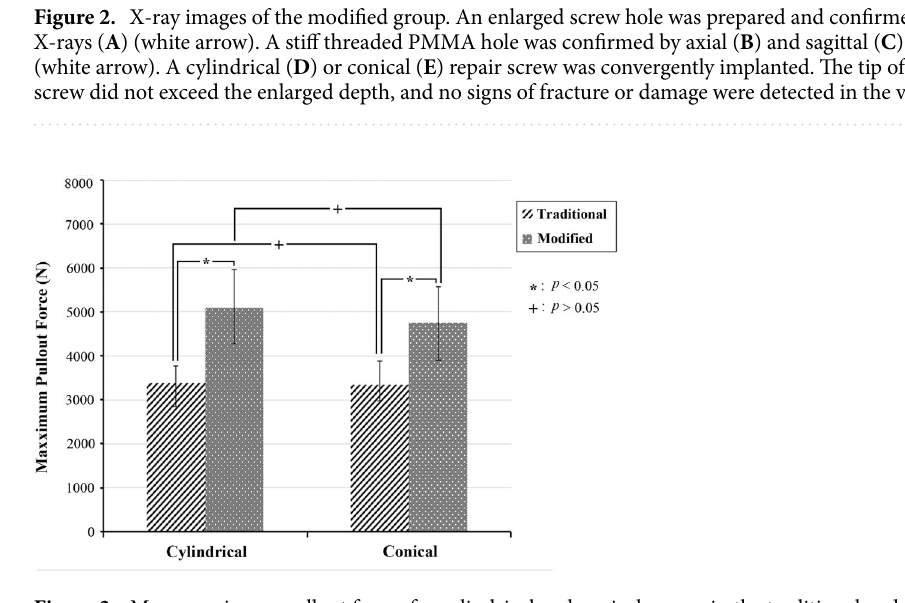
Figure 3. Mean maximum pullout forces for cylindrical and conical screws in the traditional and modified groups. In the traditional group, the cylindrical and conical repair screws had mean pullout strength values of 3386.90 ± 370.94 N and 3338.80 ± 548.37 N, respectively; these values were 5095.63 ± 859.67 N and 4755.99 ± 819.60 N in the modified group, respectively. (Groups without statistically significant difference are indicated with “+”